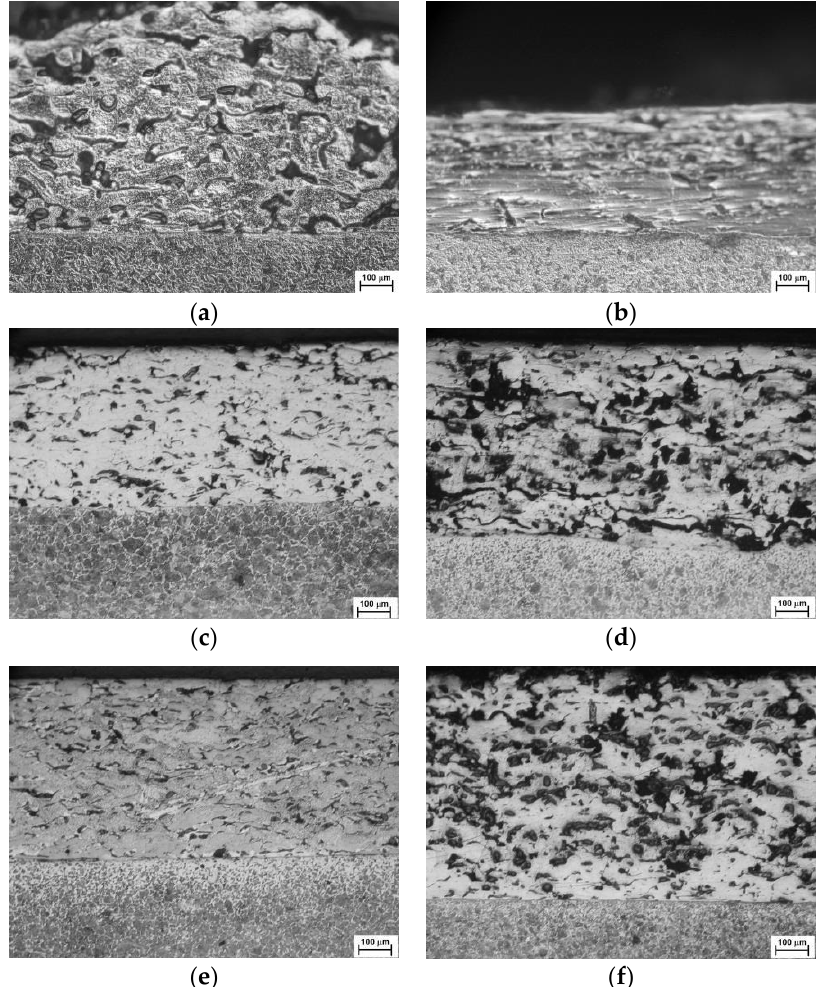
Figure 3. The microstructure for: ( a ) alloy coatings after being flame sprayed and ( b ) alloy coatings after burnishing; ( c ) alloy and ( d ) composite coatings after rolling; ( e ) alloy and ( f ) composite coatings after pressing.